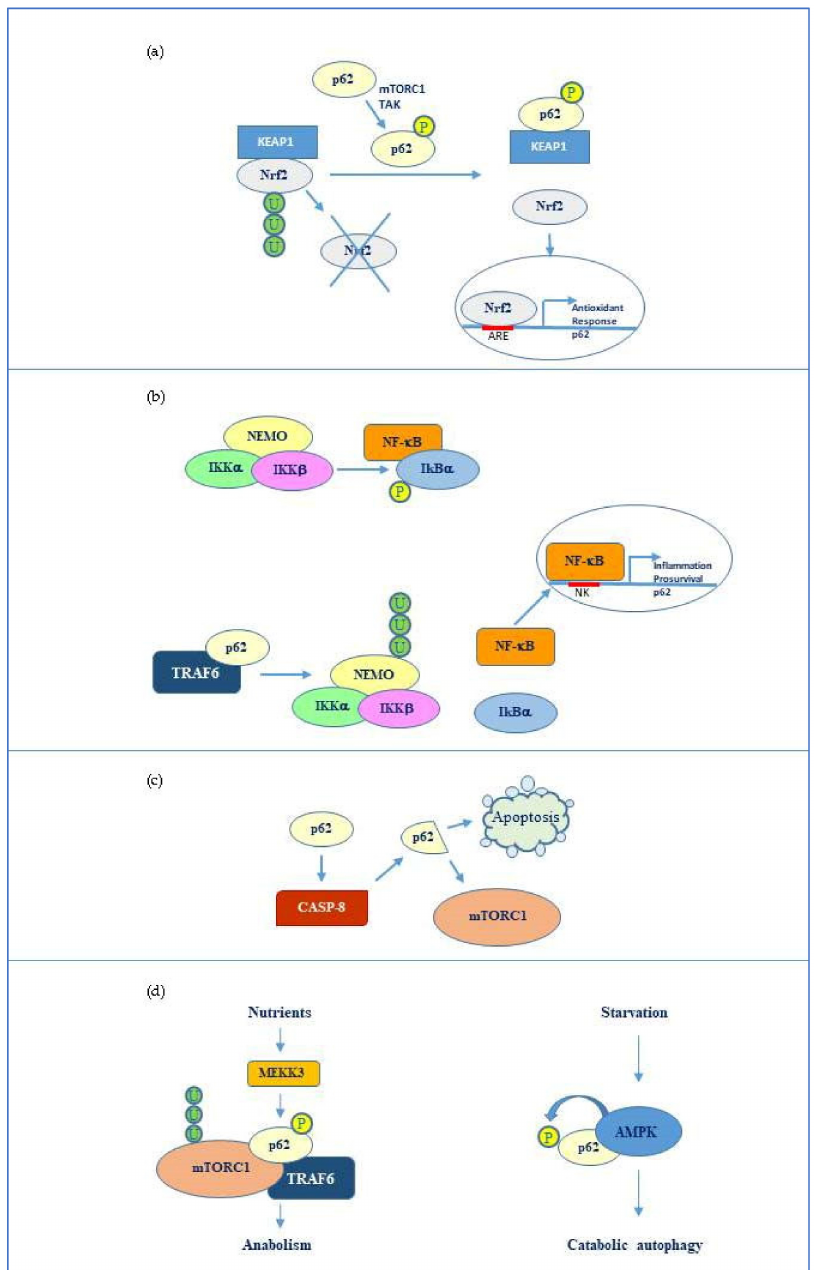
Figure 2. p62 molecular interactors and relative signalling. ( a ) Phosphorylated p62 (Ser349) activates nuclear factor (erythroid-derived 2)-like 2 (Nrf2)-mediated oxidative response and cell survival by sequestering Kelch-like ECH-associated protein 1 (Keap1). p62 expression is then activated by Nrf2 in an amplification loop. ( b ) p62 promotes NF-kappa-B essential modulator (NEMO) ubiquitination via TRAF6 favouring NF- κ B activation and consequent transcription of genes involved in inflammation and pro-survival response. NF- κ B also induces the same p62 expression. ( c ) p62 stimulates caspase-8 which in turns cleaves p62 thus promoting apoptosis or mTORC1-mediated nutrient sensing. ( d ) mTORC1 modulation by p62 via TRAF6 and stimulation of anabolism in the presence of nutrients and AMP kinase mediated p62 phosphorylation during starvation and consequent catabolic